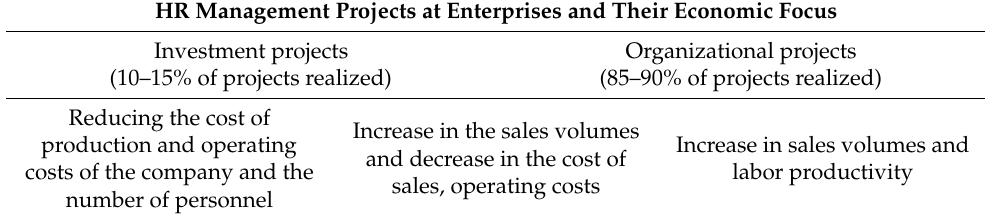
Table 1. Main types and focus of HR